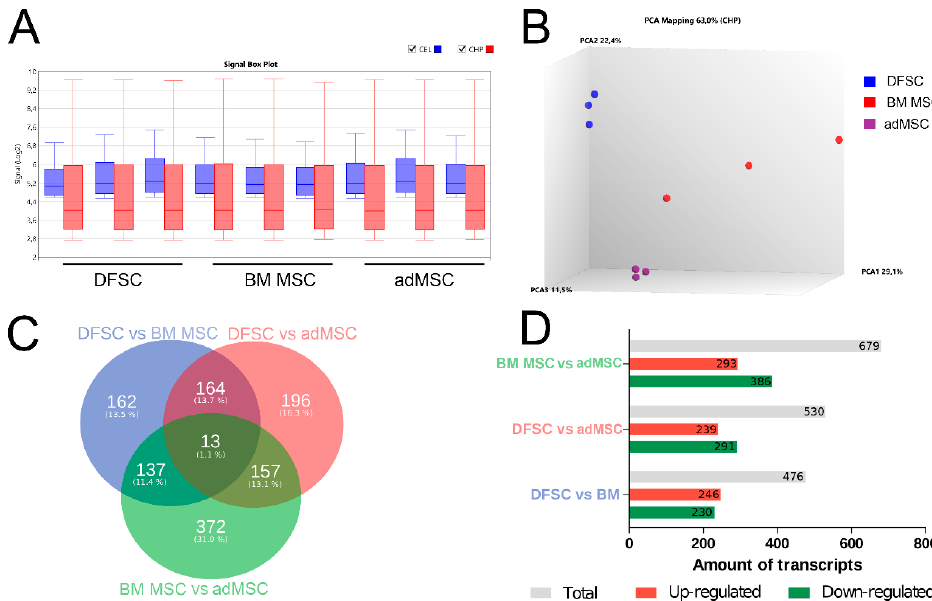
Figure 2. Comparative microarray analysis of undifferentiated dental follicle stem cells (DFSCs), bone marrow (BM) MSC, and adMSC. ( A ) Comparison of signal intensity for .cel files (blue) and .chp files (red) after normalization demonstrates su ffi cient data quality. ( B ) MSC from di ff erent sources